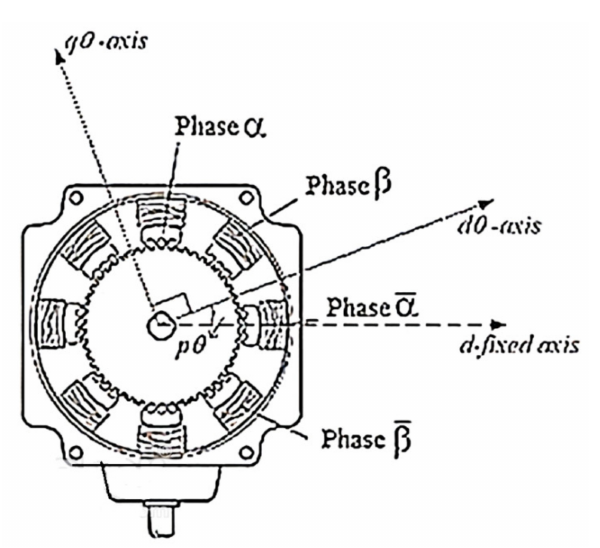
Figure 2. Cross-section of stepper motor and dq